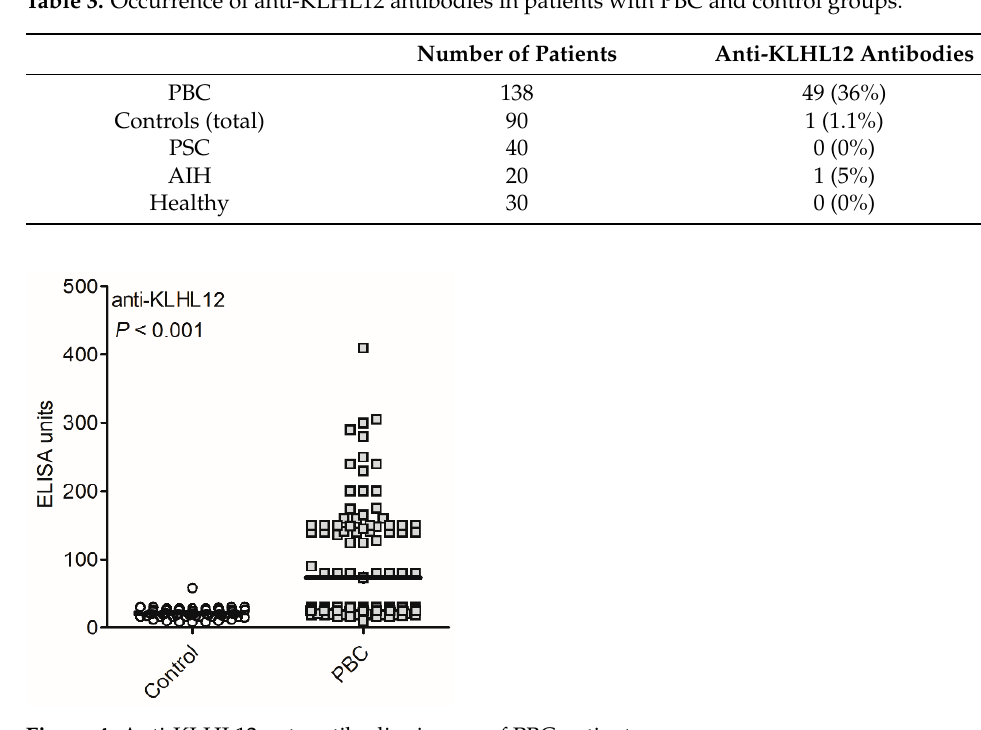
Table 3. Occurrence of anti-KLHL12 antibodies in patients with PBC and control groups